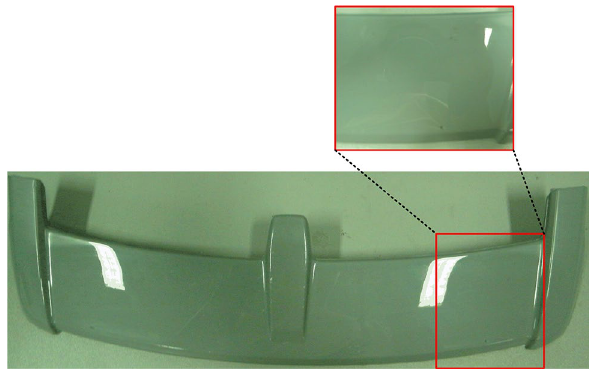
Fig. 12 Photo of high-gloss automotive spoiler molded using